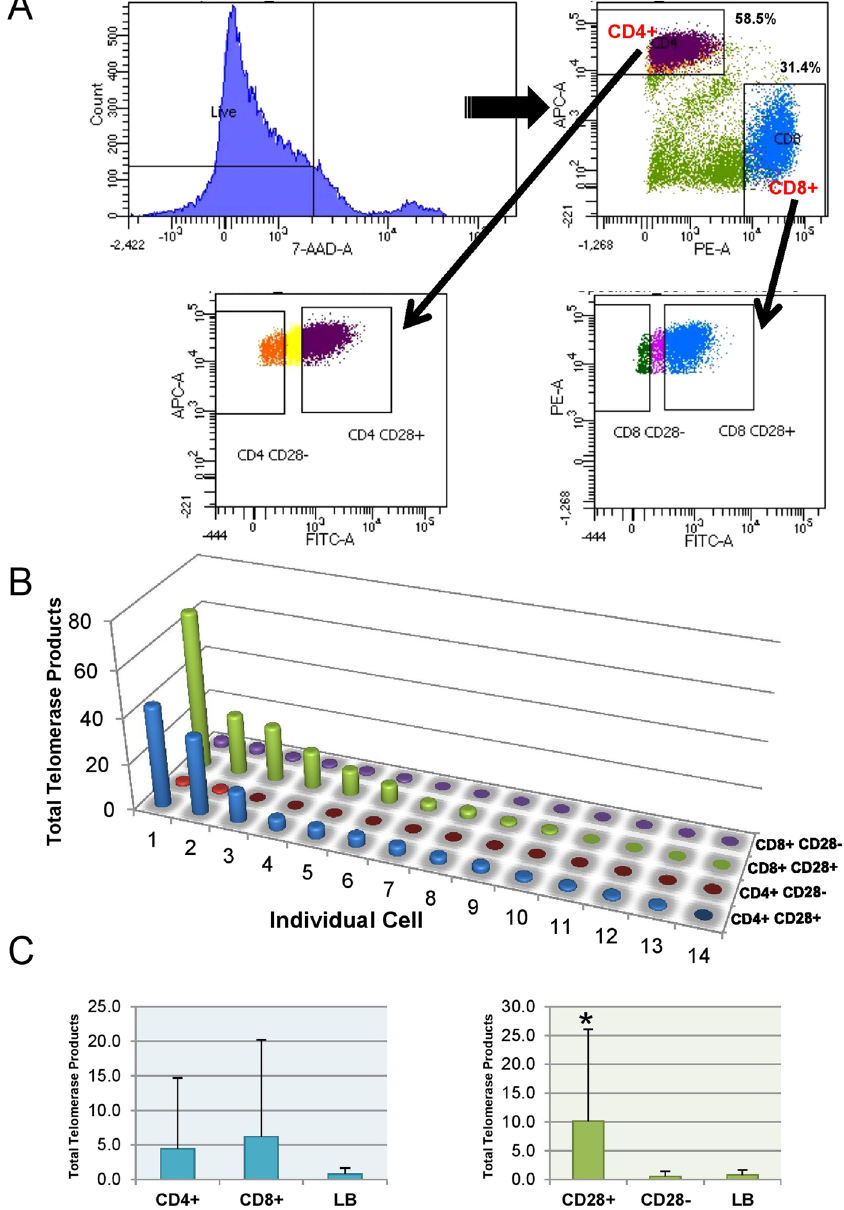
Figure 5. Telomerase activity in subsets of stimulated T cells. ( A ) Flow sorting strategy of stimulated T cells on Day 3 for separating four T cell subpopulations. ( B ) Single-cell ddTRAP on four subpopulations of T cells, i.e. CD4 + CD28 + , CD4 + CD28 − , CD8 + CD28 + , CD8 + CD28 − . ( C ) Cumulative analysis of ( B